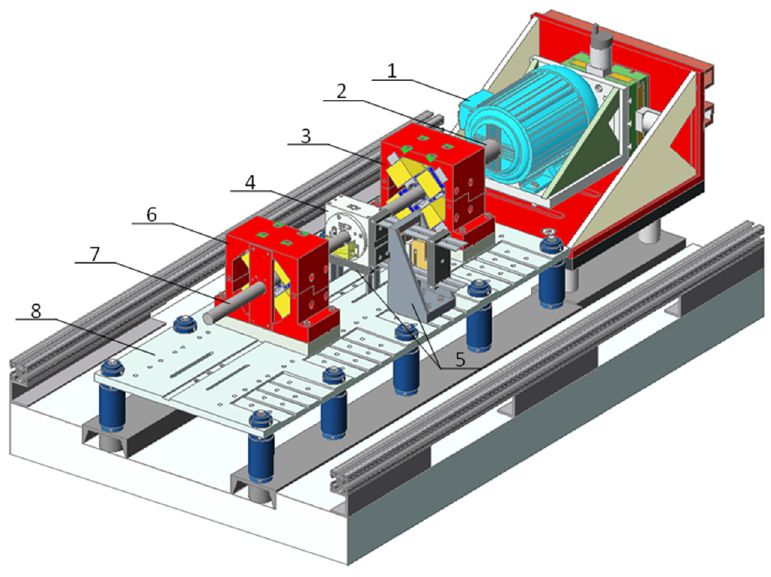
Figure 2. Schematic of the test rig configuration. (1) AC motor; (2) flexible coupling; (3–6) magnetic actuators; (4) test bearing housing; (5) bearing housing supporting structure; (7) test shaft; (8) supporting steel base.